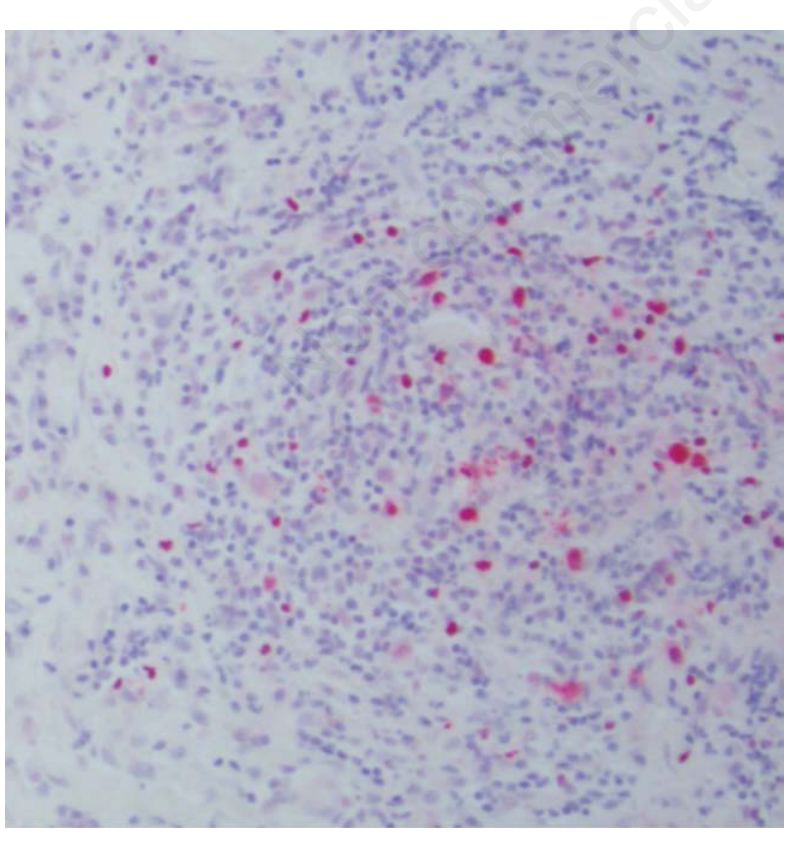
Figure 3. Positive in situ hybridization for Epstein-Barr virus encoded